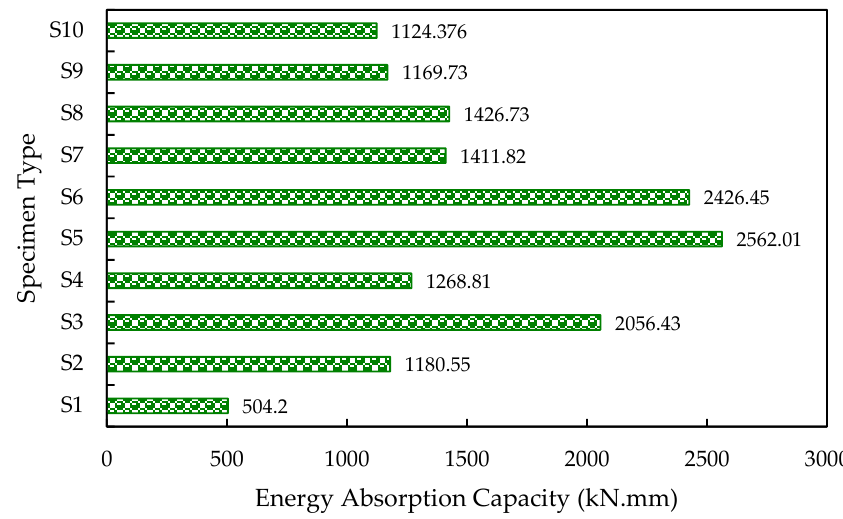
Figure 13. Energy-absorbing capacity of the ICF-based wall panels.